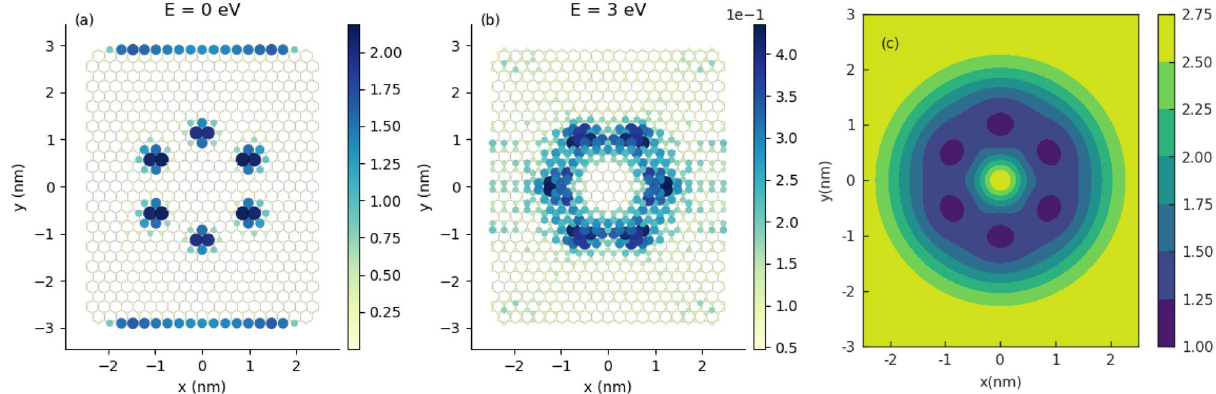
0 and = 2 nm, σ 1nm . The LDOS have G = =